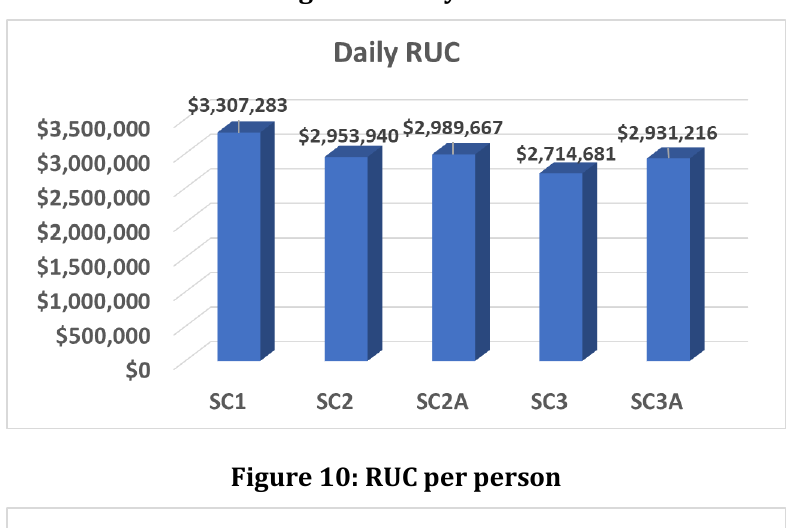
Figure 10: RUC per